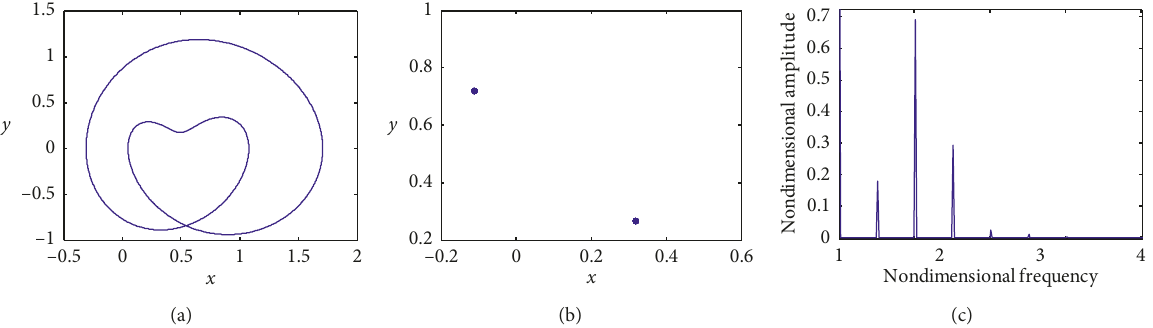
Figure 7: Dynamic response ( f � 0 . 5): (a) phase portrait; (b) Poincar´e map; (c) frequency spectrum. 2